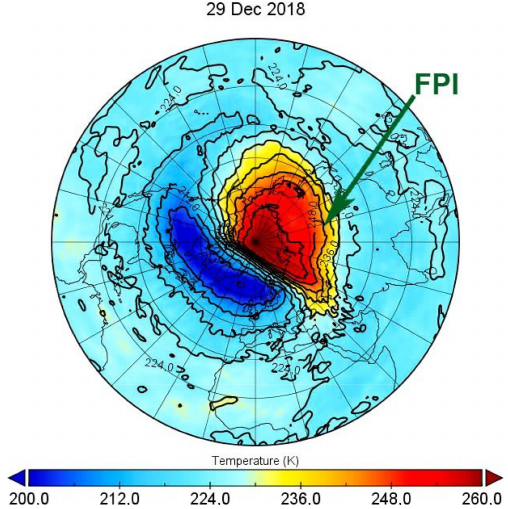
Figure 10. Same as Fig. 4.